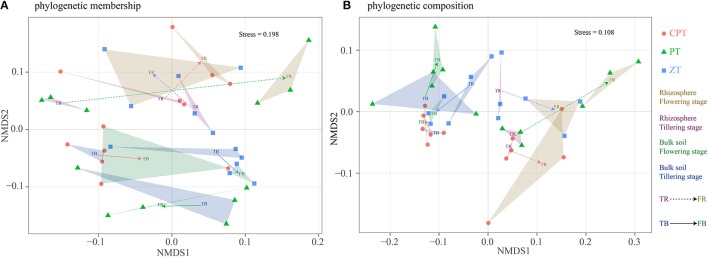
Fungal community structure indicated by non-metric multi-dimensional scaling (NMDS) plots of weighted (A) and unweighted (B) pairwise UniFrac distances. PT = Plow tillage (circle); ZT = Zero tillage (square); CPT = Chisel plow tillage (triangle).